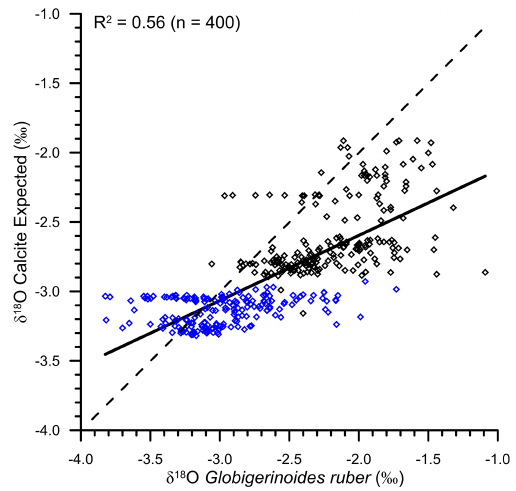
Figure 10. The scatterplot of expected δ 18 O calcite (as esti- mated from the ambient salinity–temperature) and the analysed δ 18 O ruber . The two are significantly correlated ( R 2 = 0 . 56), sug- gesting that Globigerinoides ruber correctly represents the ambient conditions. The blue diamonds are the samples collected from the Bay of Bengal, and the black diamonds represent the samples col- lected from the Arabian Sea. The dotted line represents the 1 : 1 relationship between the measured and expected δ 18